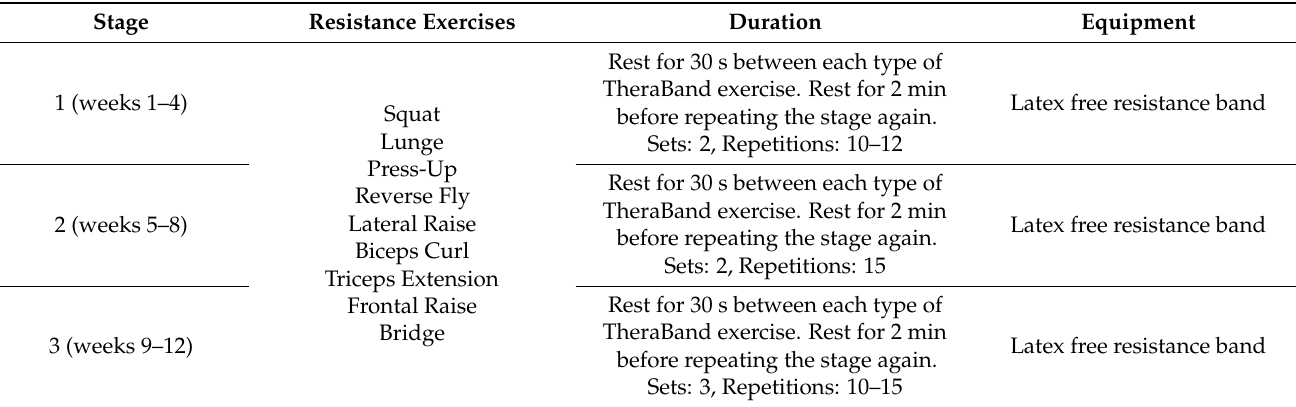
Table 1. Resistance